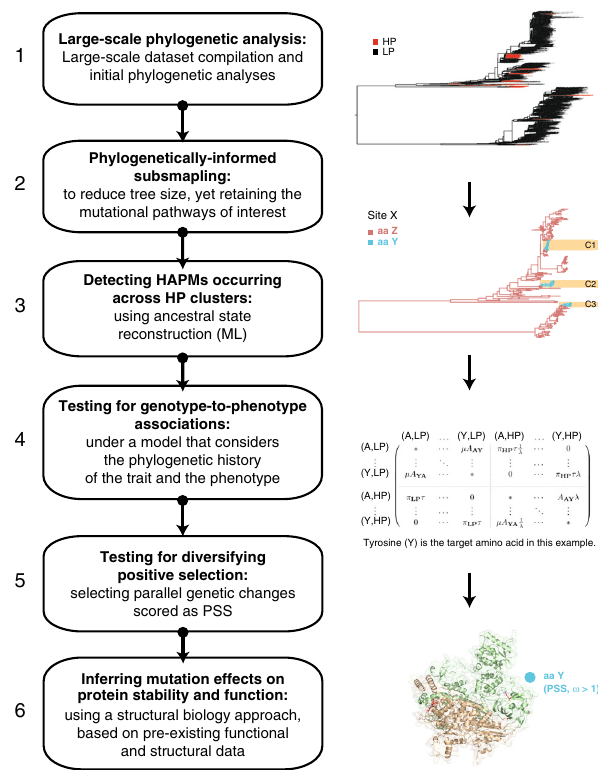
Fig. 1 Summary of analytical approach. A summary of our approach to identifying HAPMs (HP-cluster associated parallel mutations) in AIV genomes. 1. Large-scale data curation and phylogenetic analysis to detect genotypes and phenotypes (HP lineages highlighted in red). 2.